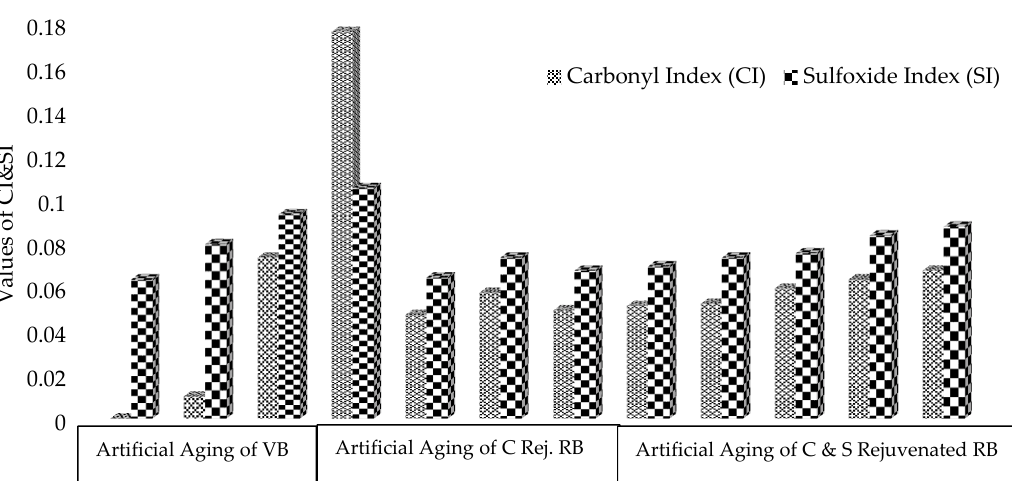
Figure 7. Effect of rejuvenation and aging on carbonyl and sulfoxide indices of binders.